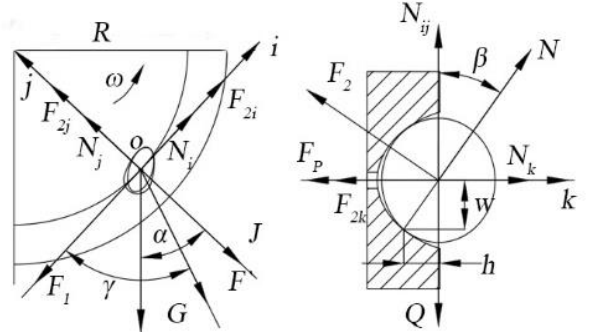
Figure 10. Analysis of the forces on seeds in the seed suctioning zone: G is the seed’s own gravity, N ; F P is the seed suction hole suction force, N ; J is the centrifugal force, N ; F 1 is the inter-seed friction force set in the o i negative direction, N ; F 2 is the frictional force between the seed and the surface of the seed-sucking recess, in a direction perpendicular to the support force N , N ; F 2 i is the component force of F 2 in the direction of o i , N ; F 2 j is the component force of F 2 in the direction of o j , N ; F 2 k is the component force of F 2 in the direction of o k , N ; N is the total support force of the seed-sucking recess in the direction perpendicular to the contact point of the recess, N ; N i is the component force of N in the direction of o i , N ; N j is the component force of N in the direction of o j , N ; N k is the component force of N in the direction of o k , N ; f 1 is the coefficient of friction between the seeds; f 2 is the coefficient of friction between the seeds and the surface of the seed-sucking recess; α is the seed-filling angle, ◦ ; β is the slope angle of the suction groove, ◦ ; ω is the angular speed of rotation of the seed tray, rad/s; γ is the angle between the combined force F (cid:48) and the centrifugal force J , ◦ ; m is the mass of the seed, kg; R is the radius of rotation of the center of the suction hole of the seed tray, mm; P is the critical suction vacuum degree of the gas chamber, Pa; S is the stable suction area, mm 2 ; Q is the combined force of F 1 , J and G , N ; F (cid:48) is the combined force of J and G , N ; h is the depth of the contact point between the seed and the suction groove, mm; and w is the width of the contact point between the seed and the suction groove,